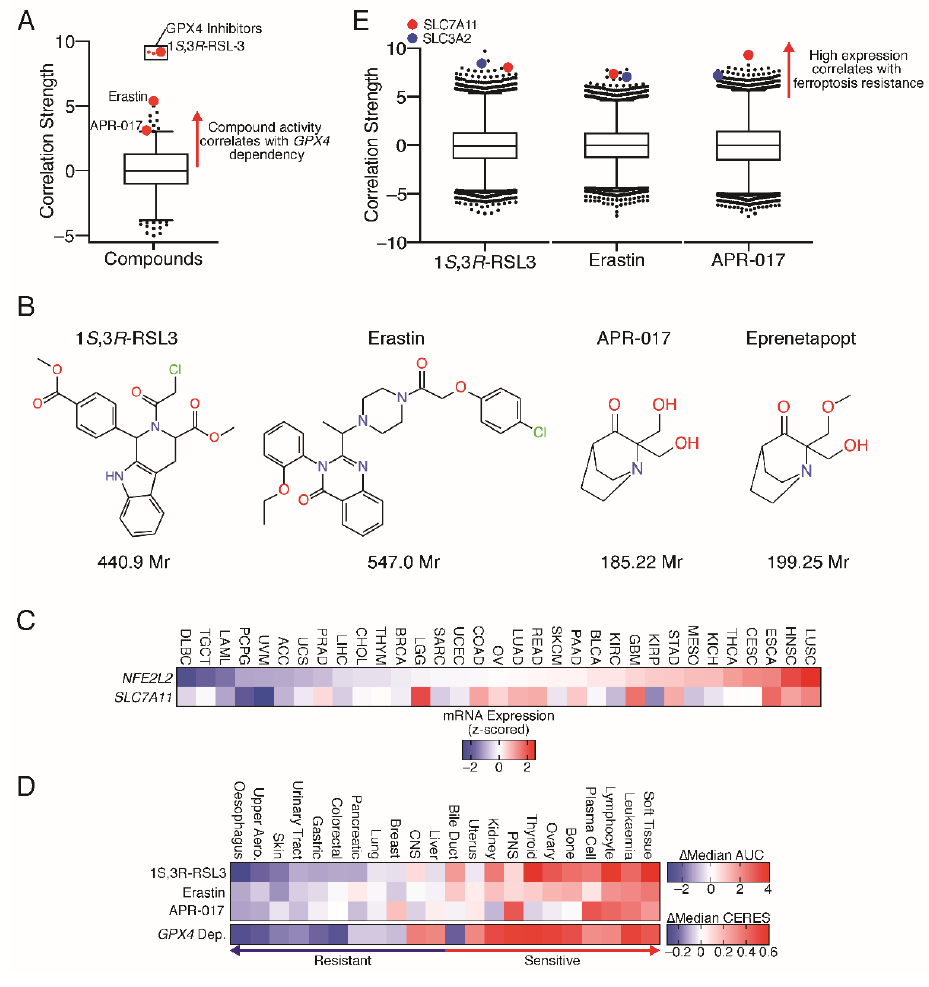
Figure 2. DepMap and TCGA data ( A ) Box-and-whisker plot (1st–99th percentile) of Fischer’s transformed z-scored Pearson correlation strength of GPX4 dependency and the 481 Cancer Therapeutic Response Portal v2 (CTRPv2) compound activity data across ~700 cancer cell lines. Red dots indicate examples of ferroptosis inducers. ( B ) Chemical structures and molecular weights (Mr) of ferroptosis inducers. ( C ) Heatmap of gene expression of NFE2L2 and SLC7A11 in patients with cancer were analysed from the TCGA, cancer type ordered by NFE2L2 expression. ACC, adrenocortical carcinoma; BLCA, bladder urothelial carcinoma; BRCA, breast invasive carcinoma; CESC, cervical squamous cell carcinoma and endocervi- cal adenocarcinoma; CHOL, cholangiocarcinoma; COAD, colon adenocarcinoma; DLBC, lymphoid neoplasm diffuse large B - cell lymphoma; ESCA, oesophageal carcinoma; GBM, glioblastoma multiforme; HNSC, head and neck squamous cell carcinoma; KICH, kidney chromophobe; KIRC, kidney renal clear cell carcinoma; KIRP, kidney renal papillary cell carci- noma; LAML, acute myeloid leukaemia; LGG, brain lower grade glioma; LIHC, liver hepatocellular carcinoma; LUAD, lung adenocarcinoma; LUSC, lung squamous cell carcinoma; MESO, mesothelioma; OV, ovarian serous cystadenocarci- noma; PAAD, pancreatic adenocarcinoma; PCPG, pheochromocytoma and paraganglioma; PRAD, prostate adenocarci- noma; READ, rectum adenocarcinoma; SARC, sarcoma; SKCM, skin cutaneous melanoma; STAD, stomach adenocarci- noma; TGCT, testicular germ cell tumours; THCA, thyroid carcinoma; THYM, thymoma; TPM, transcripts per million; UCEC, uterine corpus endometrial carcinoma; UCS, uterine carcinosarcoma; UVM, uveal melanoma. ( D ) Heatmap of sen- sitivity to ferroptosis inducers, RSL3, Erastin, Eprenetapopt analogue (APR-017), and GPX4 dependency across ~700 can- cer cell lines. Cancer lineages ordered by sensitivity. AUC, area under the curve (compound activity); CERES, copy-num- ber adjusted gene dependency score. ( E ) Box-and-whisker plot (1st-99th percentile) of Fischer’s transformed z-scored Pear- son correlation strength of RSL3, Erastin and Eprenetapopt analogue (APR-017) activity and genome-wide expression data across ~700 cancer cell lines. Red dot indicates SLC7A11 and blue dot indicates SLC3A2, which encode system x c- . Data accessed from www.depmap.org (accessed 30 March 2021) and www.cbioportal.org (accessed 30 March 2021).